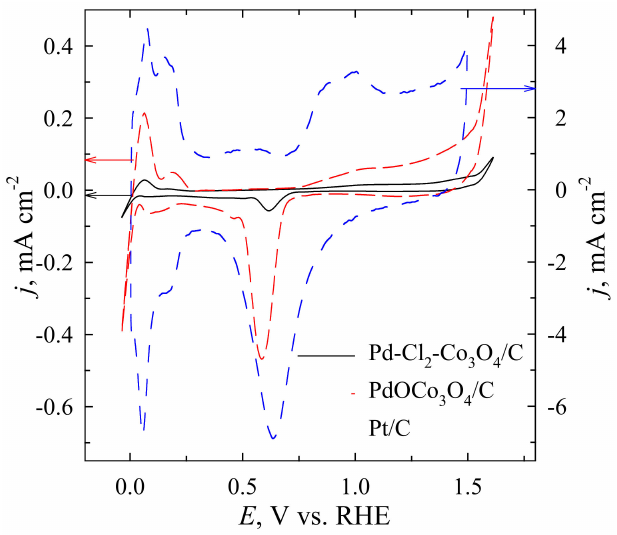
Figure 1. CVs of the investigated catalysts recorded in an Ar-deaerated 0.5 M H 2 SO 4 solution at 50 mV s − 1